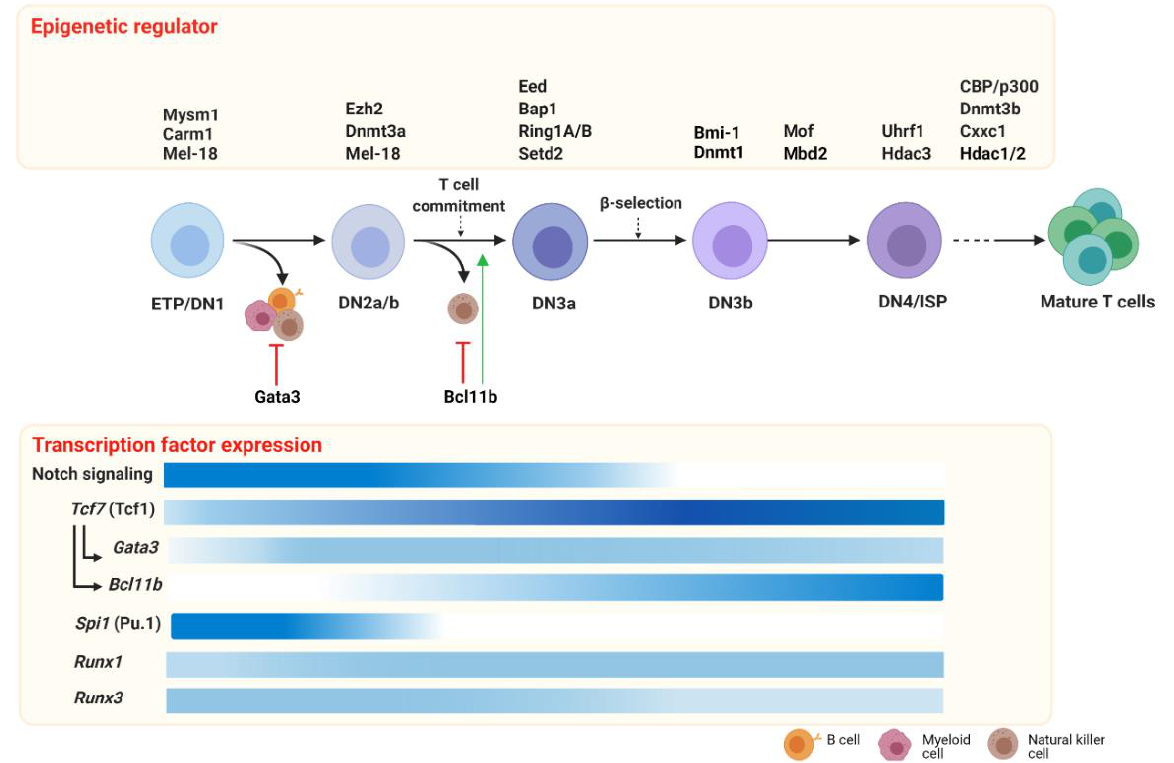
Figure 2. Epigenetic regulators and transcription factors driving early T cell development. In the thymus, T cell development, triggered by the Notch signaling pathway, requires the expression of key transcription factors (lower panel) and epigenetic modifiers (upper panel). During the first developmental stages, ETP and DN2 cells retain lineage plasticity, most likely sustained by non-T cell transcription factors such as Pu.1 and inhibited by T-cell factors such as Gata3 and Bcl11b (red arrows). The potential to develop myeloid, B and NK cells is shut down at the T cell commitment checkpoint during the transition to the DN2-DN3 stage, which is promoted by Bcl11b (green arrow). DN3b are selected after a successful TCR gene rearrangement ( β selection) that, after the last immature stages (DN4/ISP), can progress toward mature CD4+ or CD8+ TCR αβ + T cells. In the lower panel, the expression patterns of the key transcription factors of early T cells are indicated (the color’s intensity correlates with the gene expression level; darker color indicates a higher expression). Early T cell development is dynamically orchestrated by epigenetic regulators that contribute in shaping T cell survival and specification. In the upper panel, we report the epigenetic regulators at a specific stage or transition, during which the knockout murine models displayed a phenotype. Of note, conditional knockout models have often been employed to study epigenetic regulator function in T cell development. In those cases, it cannot be excluded that the requirement at other stages might exist, but this has not been investigated yet. Abbreviations: ETP: early thymic progenitors; DN: double negative; ISP: immature single positive. Created with